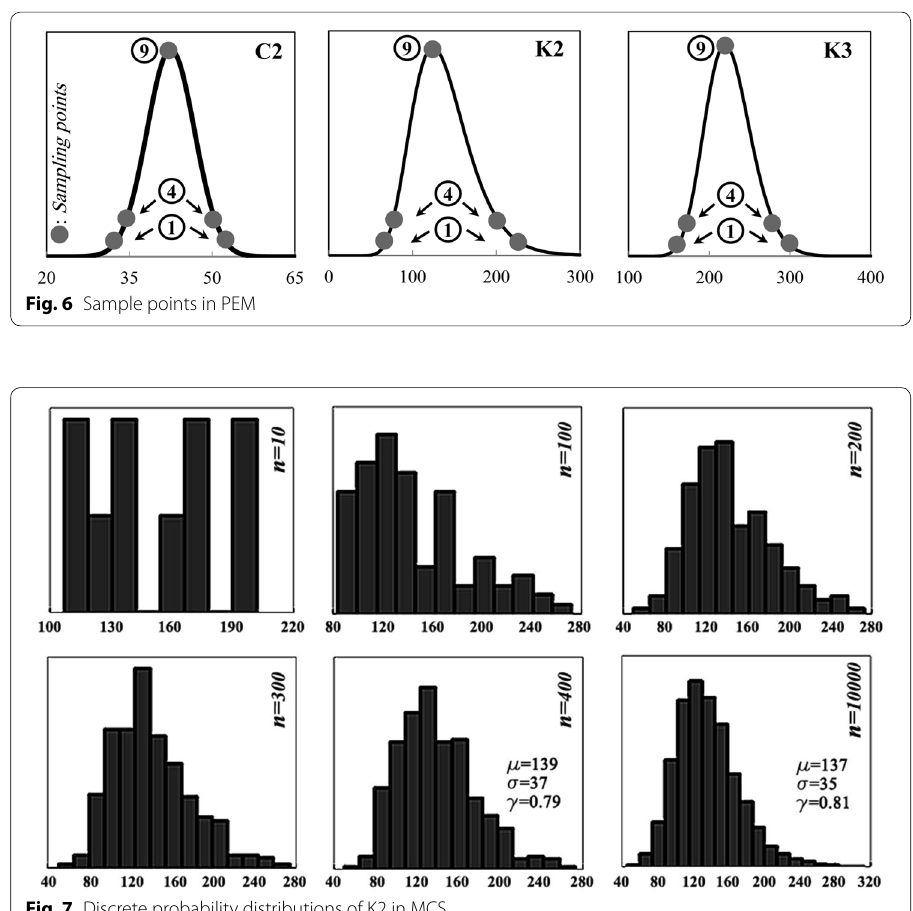
Fig. 7 Discrete probability distributions of K2 in